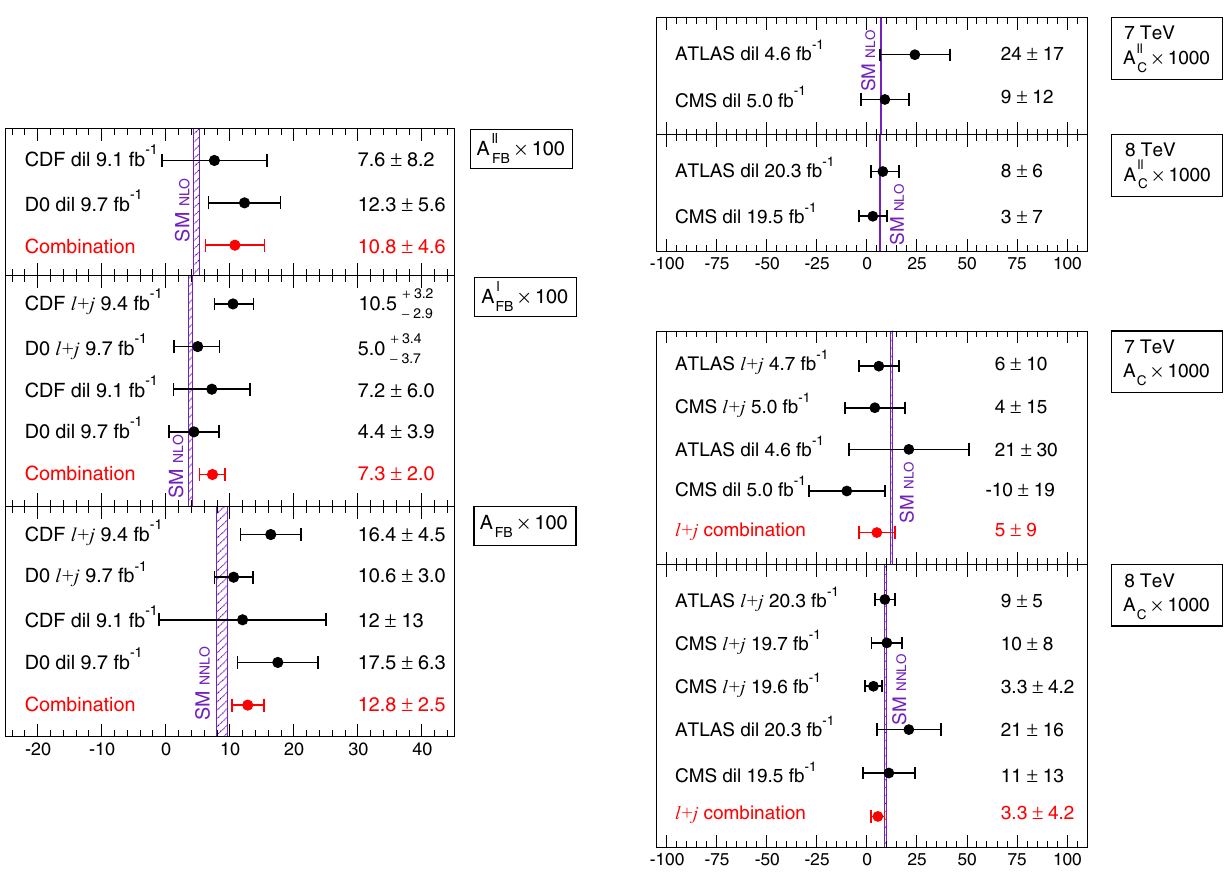
Fig. 1 SummaryofFBandchargeasymmetrymeasurements,comparedtotheSMpredictionsatNLO[8]andNNLO[16,17].Officialcombinations are displayed in red